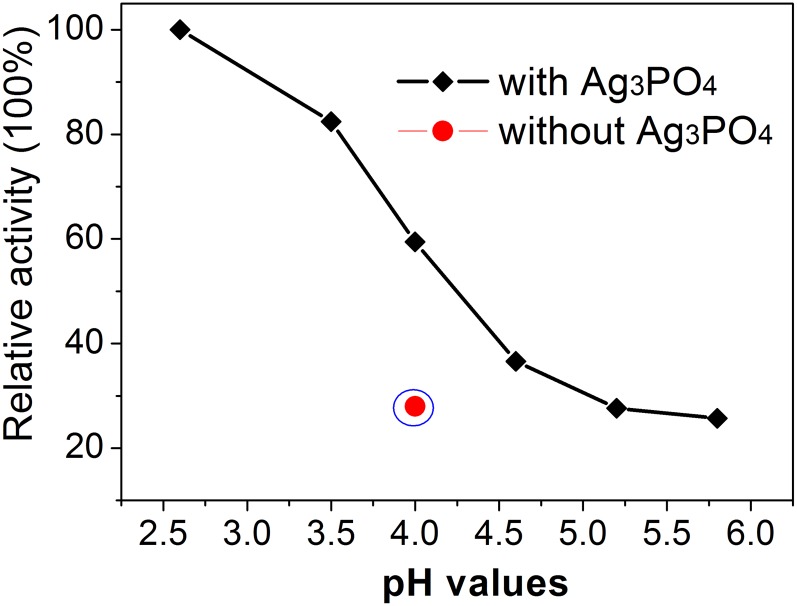
pH value-dependent peroxidase-like catalytic activity of Ag3PO4 nanocrystals.Reaction conditions: 0.3 mM of TMB, 2 mg/mL of Ag3PO4, 3.6 mM of H2O2 in 5 mL of NaAc buffer with different pH values. The reaction proceeded at 25°C with time of 30 min.